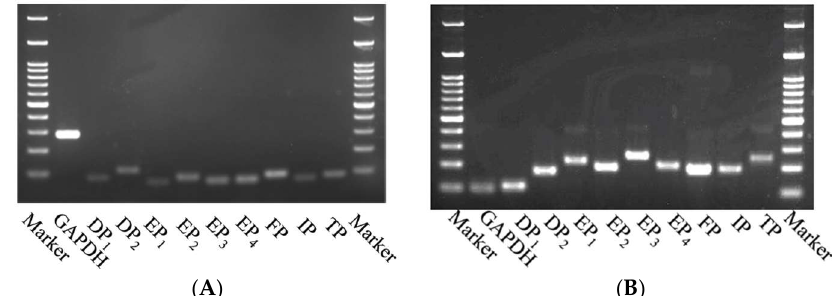
Figure 1. Expression of various prostanoid receptors in cultured human bronchial smooth muscle (BSM) cells ( A ) and murine BSMs ( B ) determined by RT-PCR analyses. Marker: M.W. markers (100 bp ladder), GAPDH: glyceraldehyde-3-phosphate dehydrogenase, DP 1 : prostaglandin D 2 (PGD 2 )